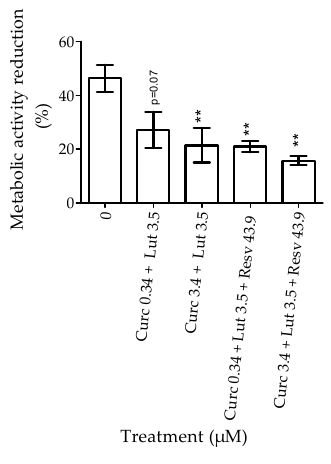
Figure 4. E ff ect of pretreatment with combination of natural agents on the reduction of metabolic activity induced by H 2 O 2 . Results are expressed as percentage ± SEM; n = 7 (each experiment was performed in triplicate). Statistical significance (*) compared to no pretreatment.